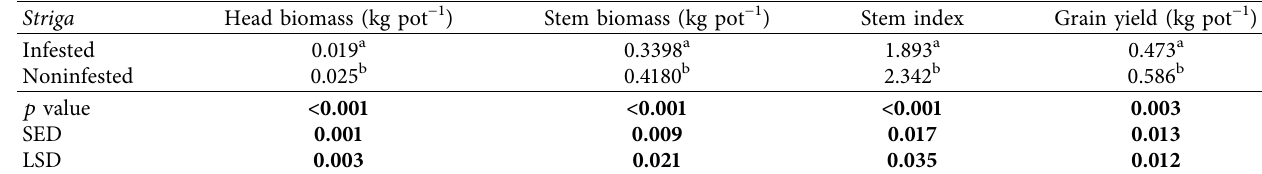
Table 10: Effect of Striga on yield parameters evaluated under glasshouse conditions.